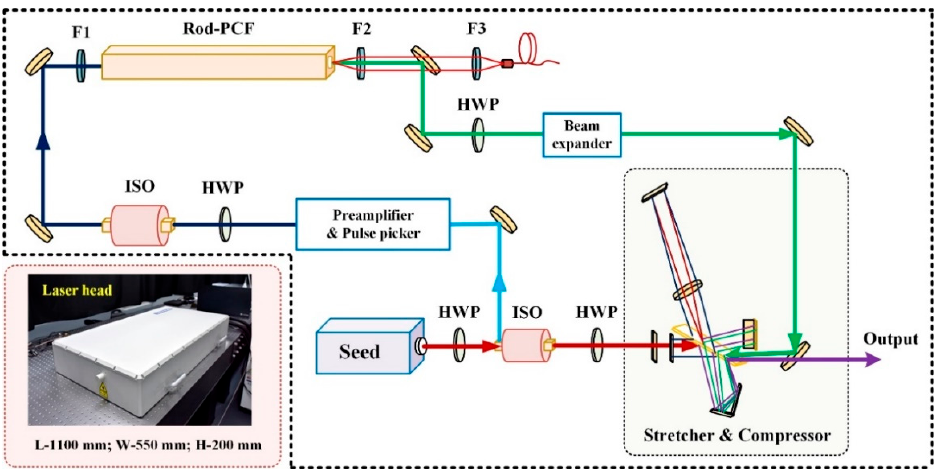
Figure 1. Schematic of the high-power chirped-pulse amplification (CPA) system. HWP, half-wave plate; ISO, isolator (EOT, Inc. Traverse City, MI, USA); F, focus lens. Inset is the photo of the laser head (excluding water-cooled chillers and power supply).